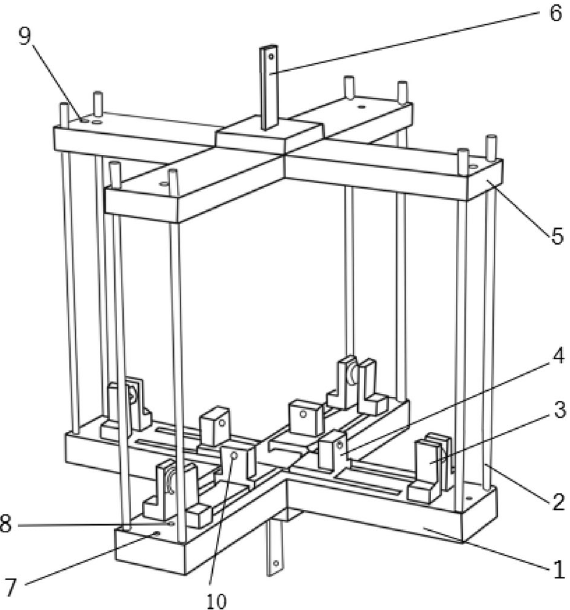
Figure 4. Test fixture (1-lower rail; 2-guide rod; 3-pulley; 4-slider; 5-upper rail; 6-clamp; 7-support rod connecting threaded hole; 8-lower rail preload threaded hole ;9- preload threaded hole on upper guide rail; 10-slider preloaded threaded hole).